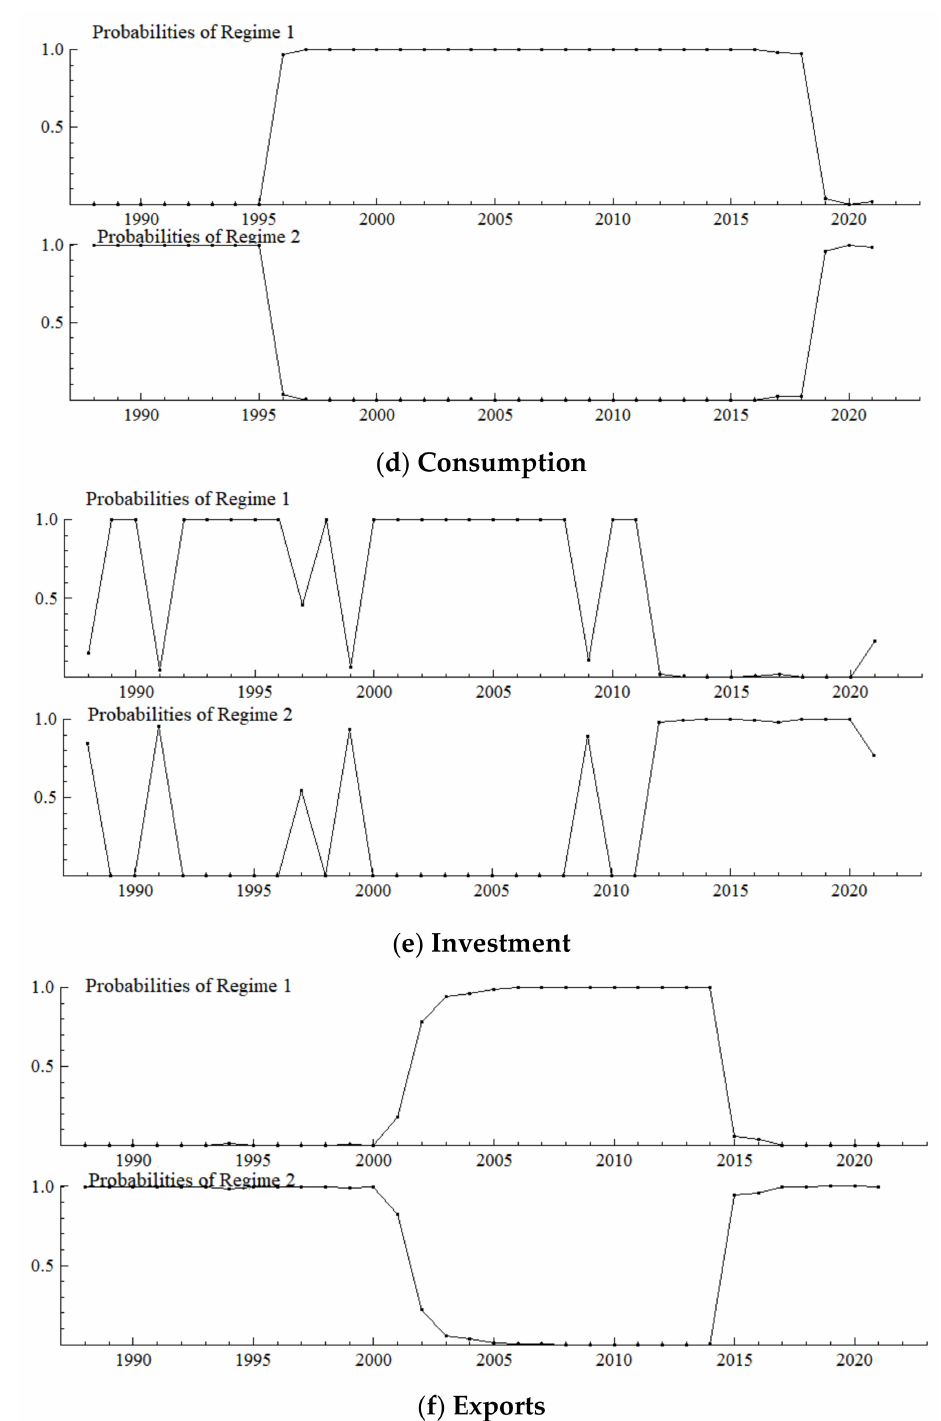
Figure 2. Probabilities of a Smooth Regime